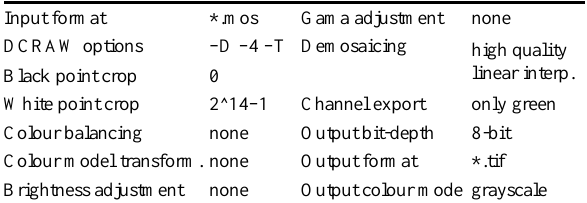
Table 1. Settings of the converter and Matlab processing.